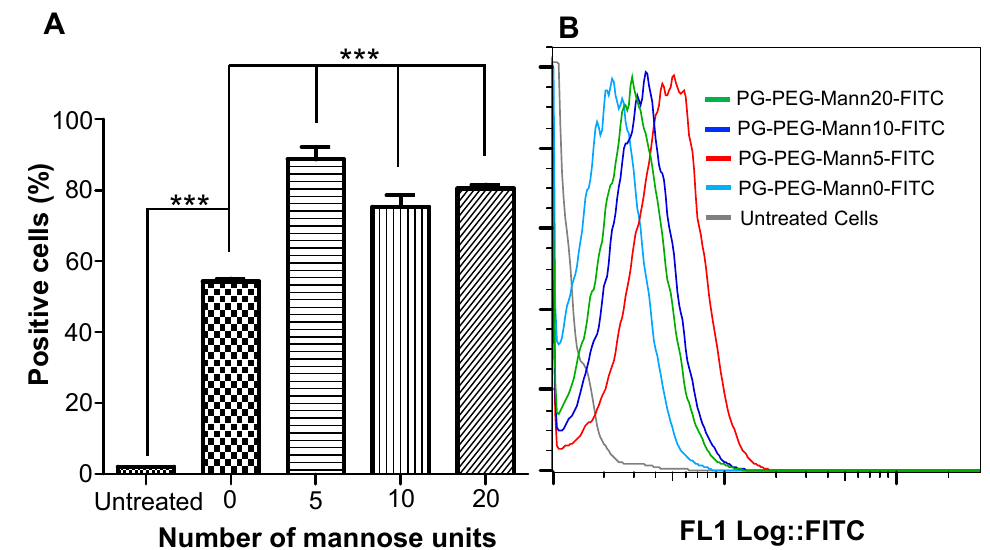
Figure 2. Cellular uptake of mannosylated PG–PEG nanocarrier. ( A ) PG–PEG–Mann(n)–FITC with n equal to 0, 5, 10 and 20 mannoses were incubated with RAW 264.7 macrophages for 24 h. Macrophages were harvested, and the unbound polymers were removed by acidic treatment. FITC fluorescence intensity was acquired on logarithmic scale and represented versus scatter side. Gate FITC-positive population was established as 2% in untreated cells. Uptake is expressed as %. Values are means ± SD; ( B ) flow cytometry histogram for uptake studies in RAW 264.7 macrophages. X-axis represents fluorescence inside the cells. Control untreated cells (gray), PG–PEG–Mann0–FITC (cyan blue), PG–PEG–Mann5–FITC (red), PG–PEG–Mann10–FITC (dark blue), PG–PEG–Mann20–FITC (green). Black asterisks indicate P values for t -Student’s test ( A ). Comparisons between untreated